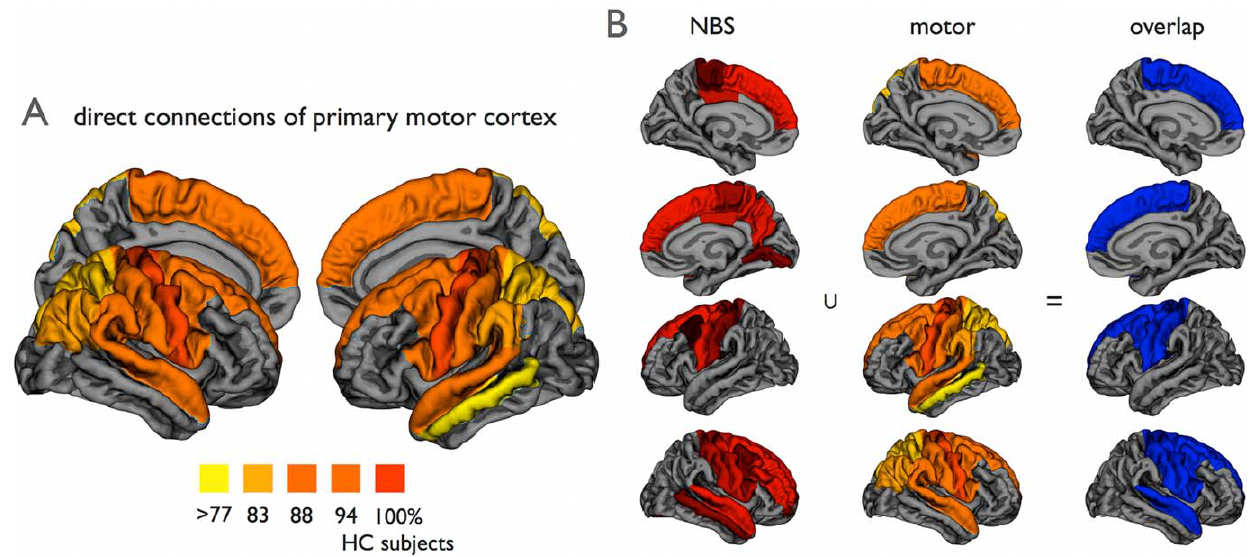
Figure 3. Overlap between motor network and impaired NBS network. (a) Direct cortical connections of the primary motor network. The direct connections of the left and right precentral gyri in the group of healthy controls are shown. Figure illustrates (per region) the percentage of healthy control subjects thatshoweda direct structural white matterconnectiontotheleftorrightprecentral gyrus.Theprimarymotornetworkwas selectedas thoseregions that were connected to the primary motor regions in the majority of healthy controls ( . 75%). (b) Figure shows the overlap (right column) between the exploratory NBS network (left column, NBSb network, Figure 2b) and the regions of the healthy motor network (middle column, showing regions of Figure3a). The impaired NBS network was found to strongly overlap the motor network (p , 0.0001, Fisher’s Exact test). Right=Right; Left=Left.